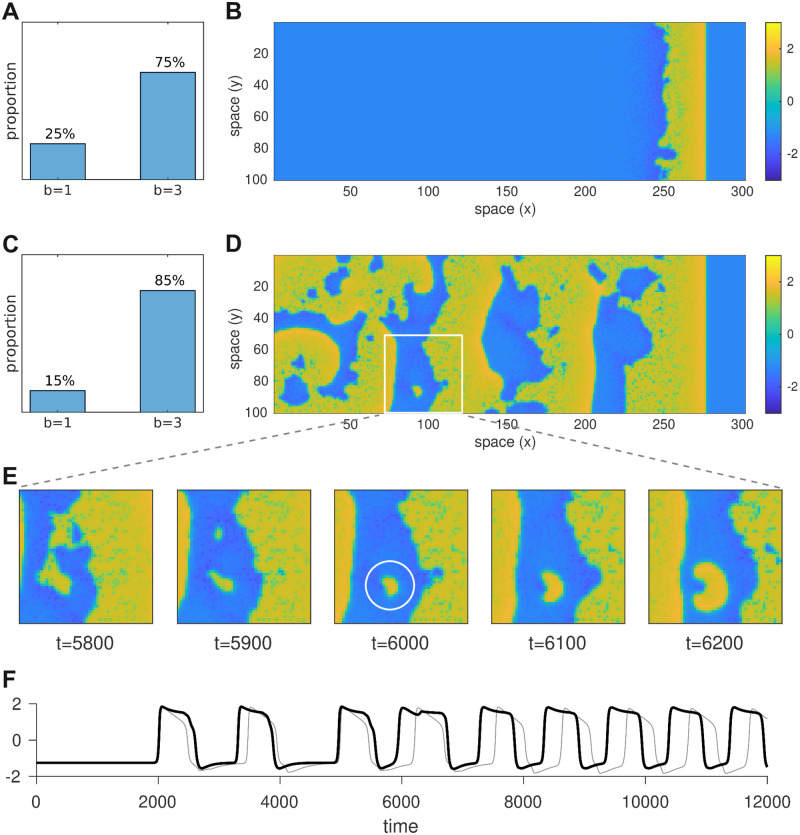
Effect of mixing monostable and bistable cells in the same tissue.Here we compare wave propagation in two simulations of 100 × 300 heterogeneous media where each cell was randomly assigned either b = 1 (monostable) or b = 3 (bistable) according to the distributions in panels A and C. A rightward traveling wave was initiated in the resting medium by briefly stimulating the cells at the left hand boundary. Snapshots of the respective simulations (t = 6000 ms) are shown in panels B and D. The former supports a functional propagating wave whereas the latter leaves self-sustained ectopic activity in its wake. The coupling strength (c = 0.6) is identical in both cases. Panel E shows successive snapshots of the 50x50 region marked with a white square. The ectopic activity in that region grew from a small cluster of cells that failed to repolarize (white circle). The time series of the cell at the center of the white circle (x = 93, y = 87) is shown in panel F (black). The light gray trace in panel F is that of a nearby cell (x = 93, y = 77). See S1 Video for an animated version of this figure.